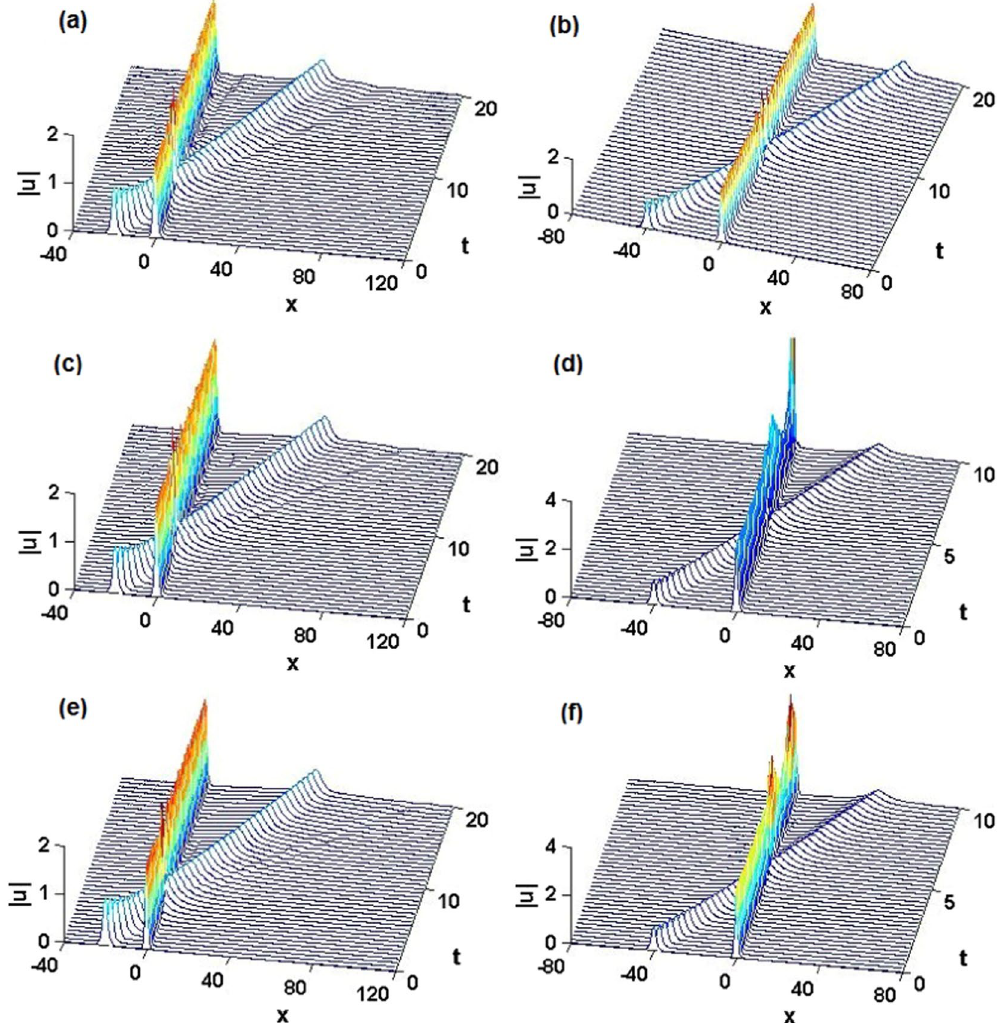
Figure 4. Collisions between exact bright solitons and boosted sech-shaped solitary pulses, produced by simulations of Eq. (1). ( a ) α θ = = . = . m 1, 0 5, 0 1 (unbroken), with the input composed of the exact 0 0 soliton (6) and the solitary pulse + . x e sech( 20) ix 1 8 , ( b ) α θ = = . = . m 1, 0 75, 0 1 (broken), with the 0 0 initial solitary pulse (unbroken), with the initial solitary pulse ix 1 8 , ( d ) α θ = = . = . m 2, (broken), with the initial solitary pulse + x (unbroken), with the initial solitary pulse . x (broken), with the initial solitary pulse + x e sech( 40) ix 4 . Other parameters are α = 1, 2, 3 for the first, second, and third row, respectively. Note that t-axes should be